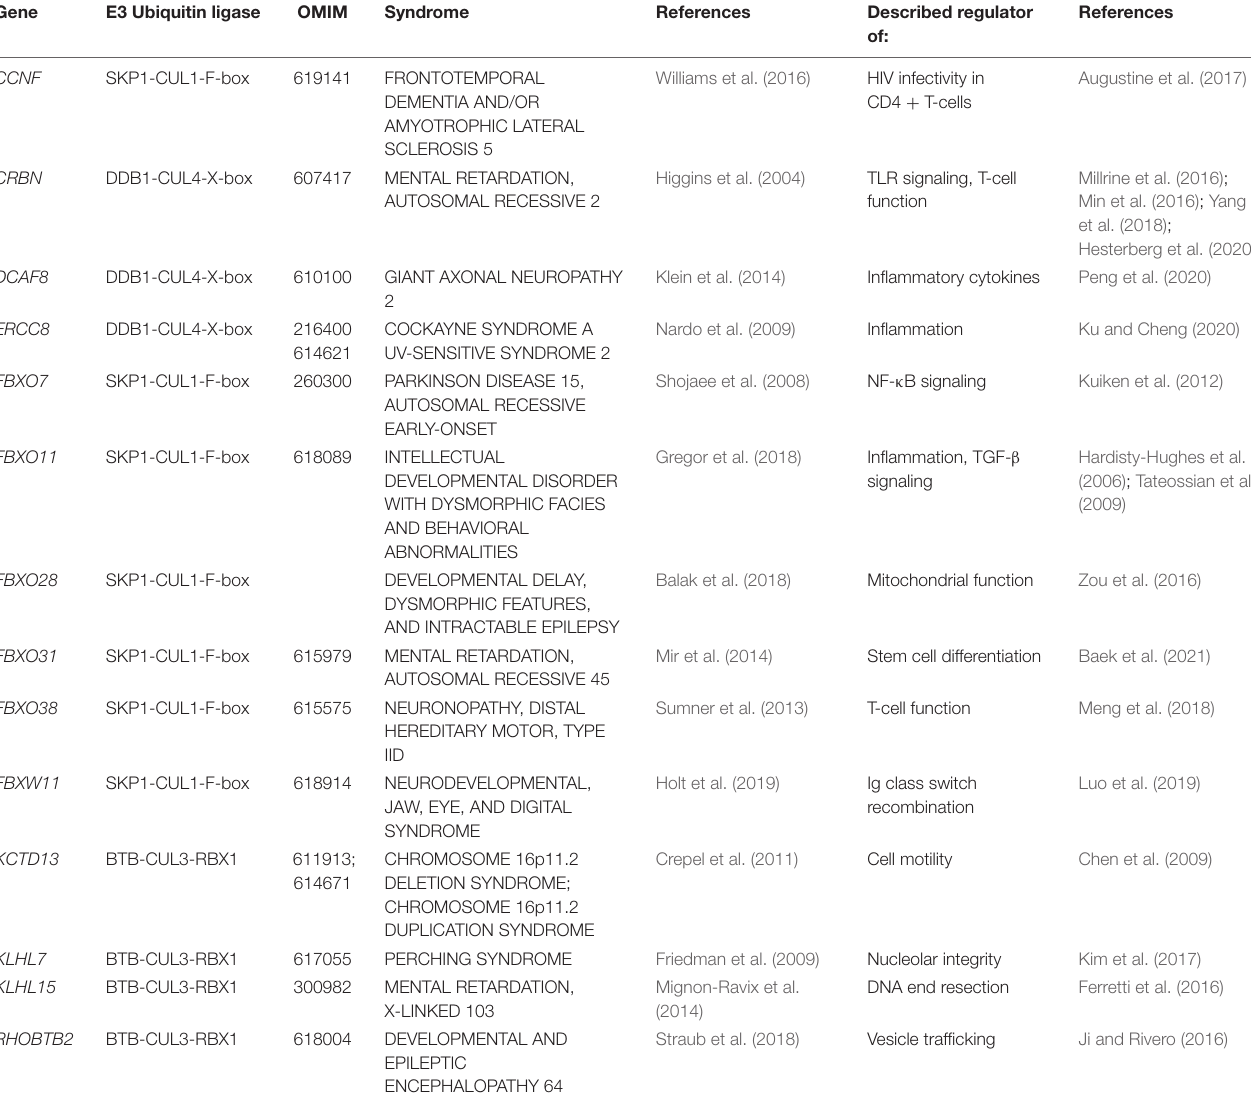
TABLE 2 | NDD-causing genes encoding CUL substrate receptors and associated syndromes.